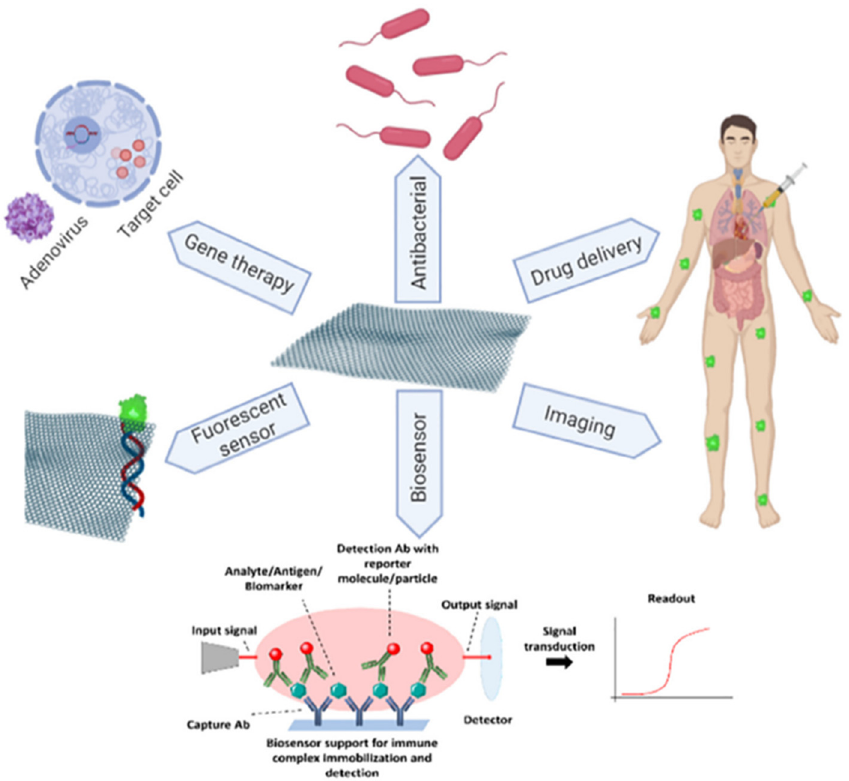
Figure 16. Various applications of graphene in biomedical field. “Reproduced with permission from [10], [FlatChem]; published by [Elsevier], 2020”.